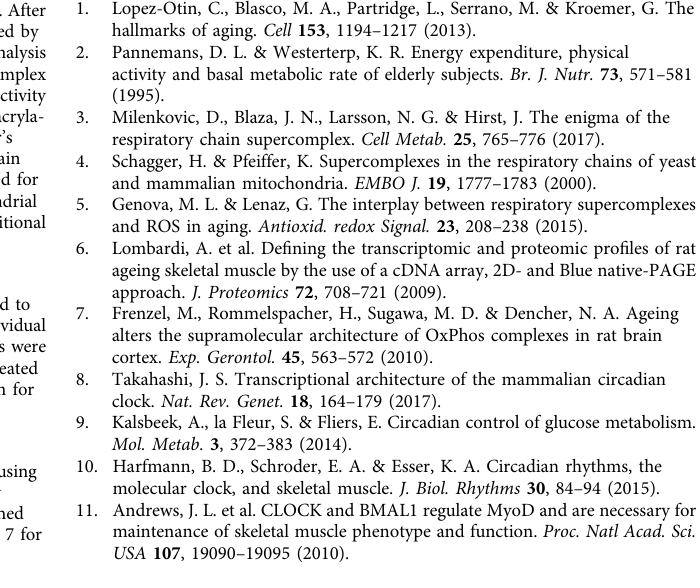
Supplementary Fig. 7. The source data underlying the graphs are provided in the Source Data Excel fi